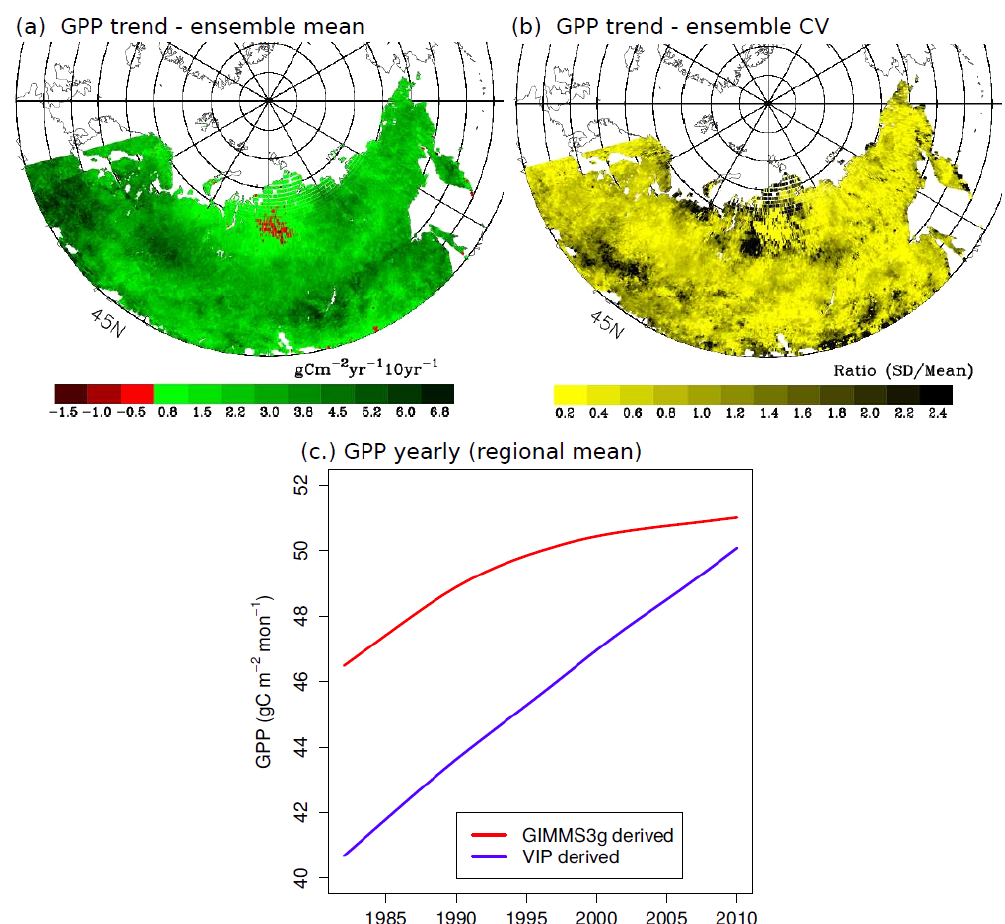
Figure 4. Change in annual GPP for GPPsat over the period 1982–2010. Panel (a) is the trend map for GPPsat, i.e. the ensemble mean (of two GPP data sets). Shades of green represent a positive trend and shades of red represent a negative trend. The trends have been derived from a linear least-squares fit to the GPP time series for GIMMS3g and VIP data sets. Trend values represent the rate of change of productivity per decade (gC(Carbon)m − 2 month − 1 10yr − 1 ). Panel (b) is the uncertainty map (uncertainty due to the use of two GPP data sets) represented by computing the coefficient of variation (CV). Darker values represent higher uncertainty and vice versa. Panel (c) shows yearly change in the regional average GPP for the data sets derived from the GIMMS3g (red) and VIP (blue) NDVI data sets. The interannual variation is smoothed using a smoothing spline using a smoothing parameter of